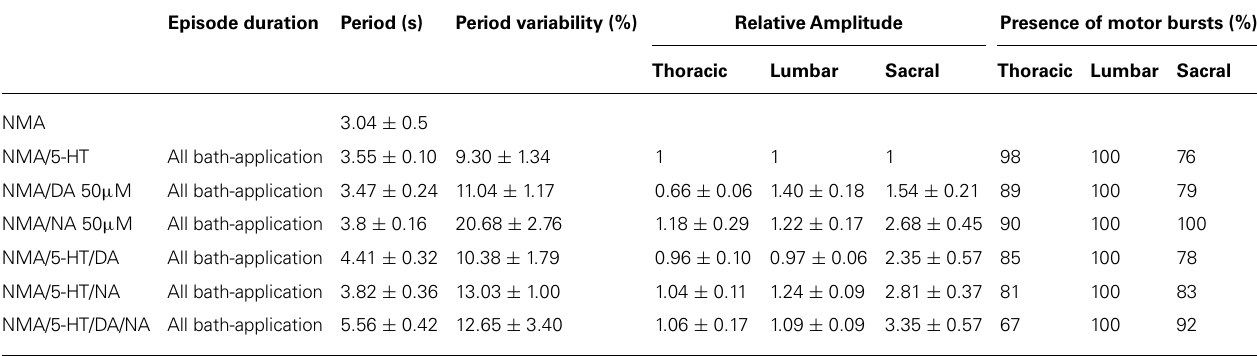
Table 1 | Summary of the effects of 5-HT, DA and